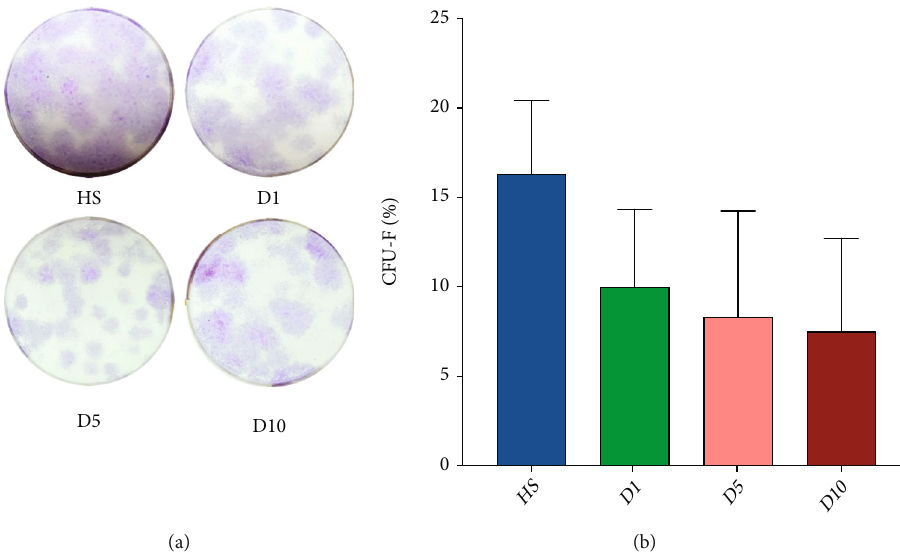
Figure 2: Colony forming unit- fi broblast assay (CFU-F assay). (a) Representative images of CFU-F assays from HS, D1, D5, and D10. (b) Results of the CFU-F assays obtained by seeding 250 cells/well. Calculation was performed using the following formula: CFU ‐ F % = colonies/250 × 100 % . The colony forming ability of polytrauma groups (D1, D5, and D10) had no signi fi cant di ff erence when compared to the HS group ( n = 4